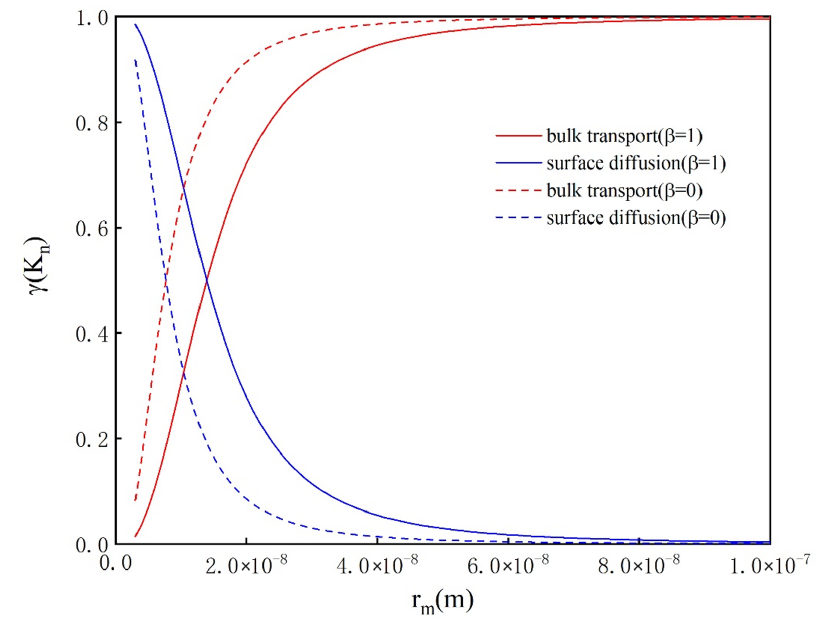
Figure 6. Under different degrees of water molecular coverage,considering K n , the ratio of flow mechanism vs. pore radius (P = 1